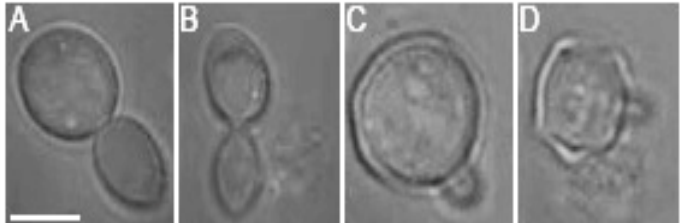
Figure 7. Images of two different S. cerevisiae cells before ( A , C ) and after ( B , D ) cell-wall rupture caused by 15 min of optical trapping at the wavelength 1064 nm with trapping laser power P c = 76 mW. The rupture always occurred during the new bud formation, more than 60 min after the end of optical trapping. Scale bar length: 5 μ m. Table 1. The summary of experimental results on the response of S. cerevisiae cells to light-induced stress (top section). Results reported by Aabo et al. in Ref. [20] (bottom section).